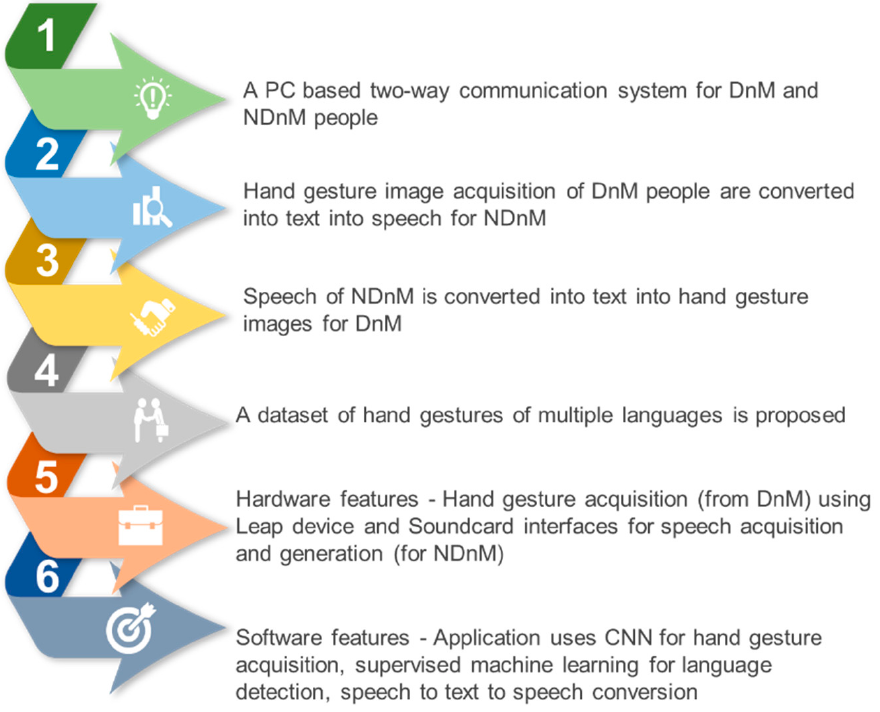
Figure 3. Novel features of the system.